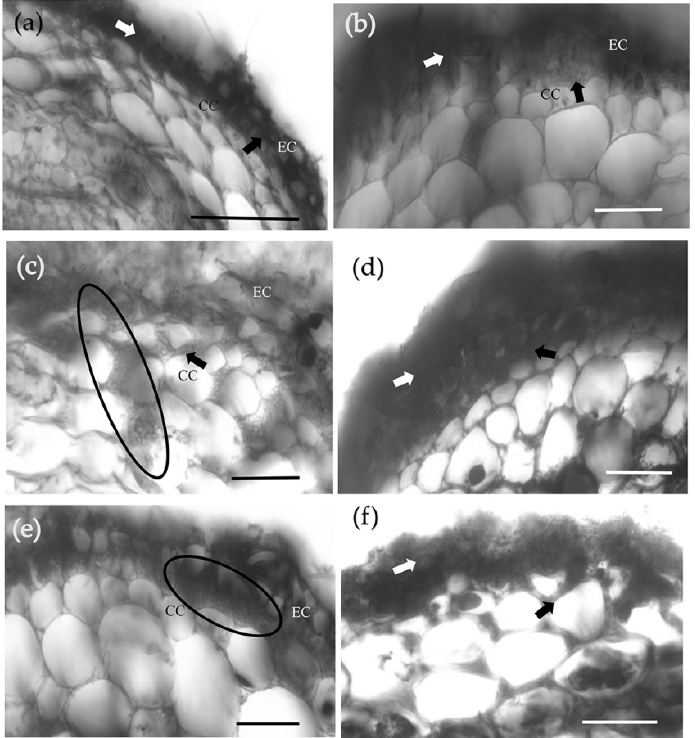
Figure 7. Effects of acibenzolar acid treatment on ECM development. Transverse cross-sections of a P. massoniana lateral root colonized by S. bovinus : ( a ) without the addition of acibenzolar acid; ( b ) in the presence of 100 μ M acibenzolar acid; ( c , d ) 300 μ M acibenzolar acid; and ( e , f ) 500 μ M acibenzolar acid. Scale bars = 50 μ m. Black arrows and ellipses indicate Hartig nets, white arrows indicate the mantle. Abbreviations: CC, cortical cells; EC, epidermal cells.